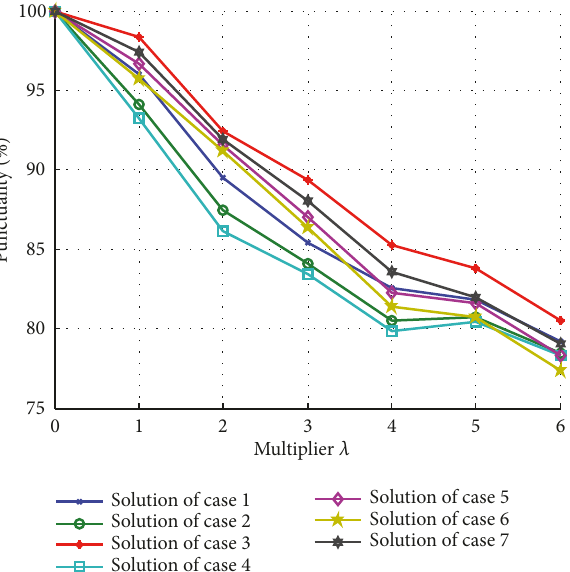
Figure 5: The punctualities under different multiplier 𝜆